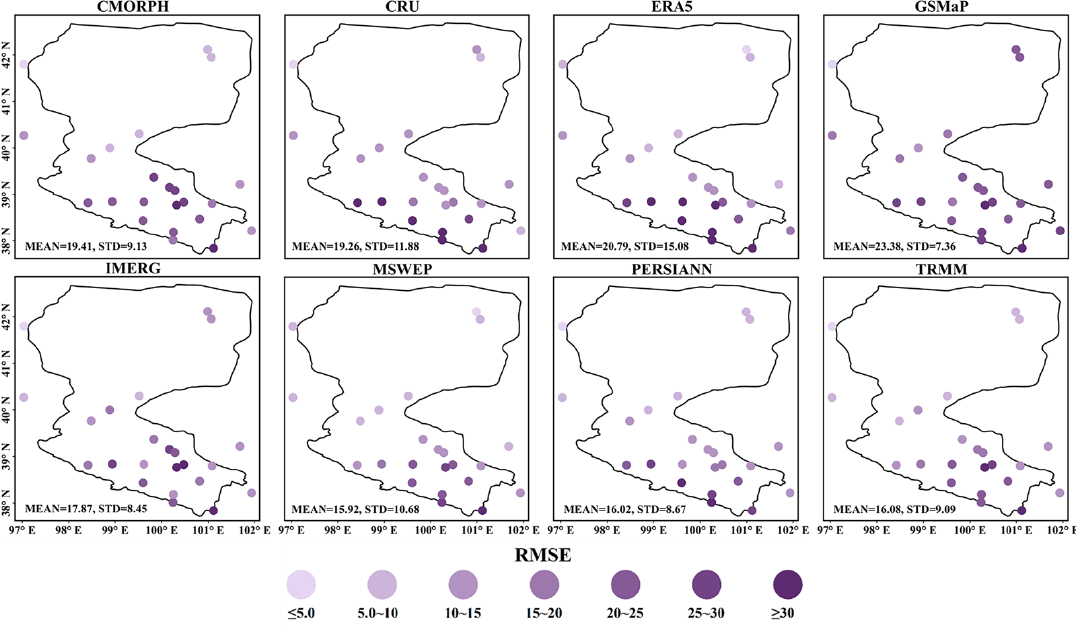
Figure 11. Spatial distributions of RMSE of monthly precipitation estimates from each product for stations over the HRB during 2016–2019.